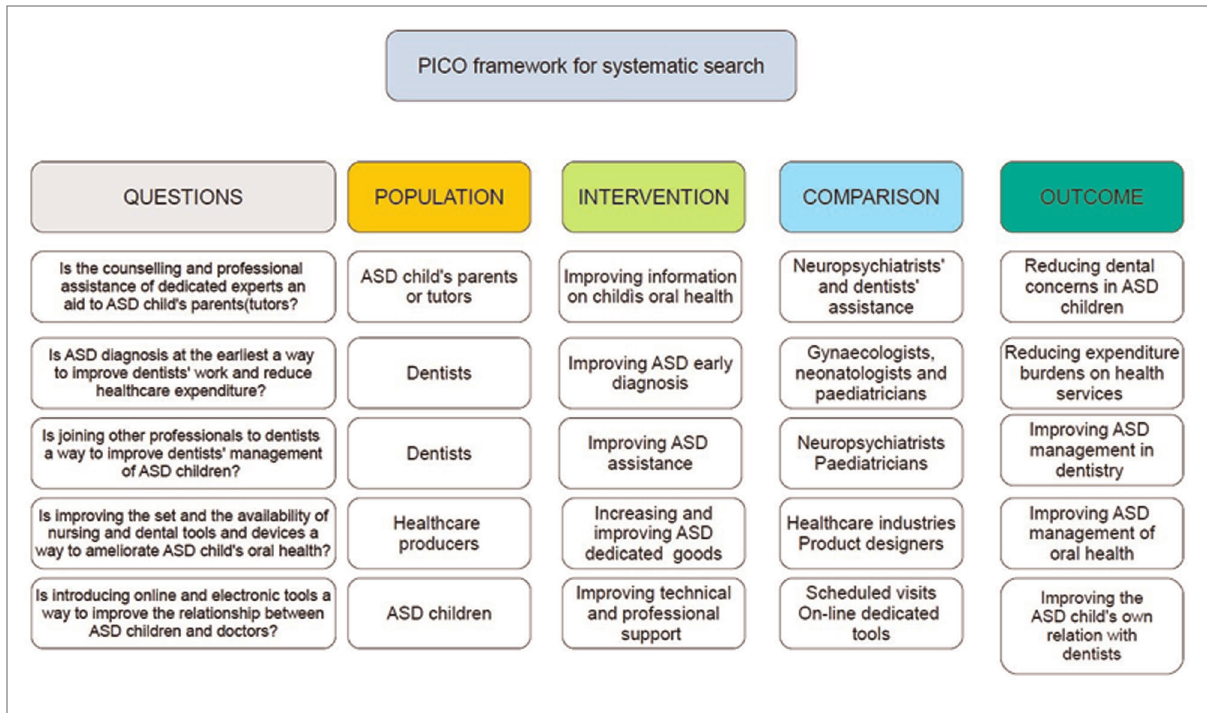
FIGURE 2 PICO framework of the search